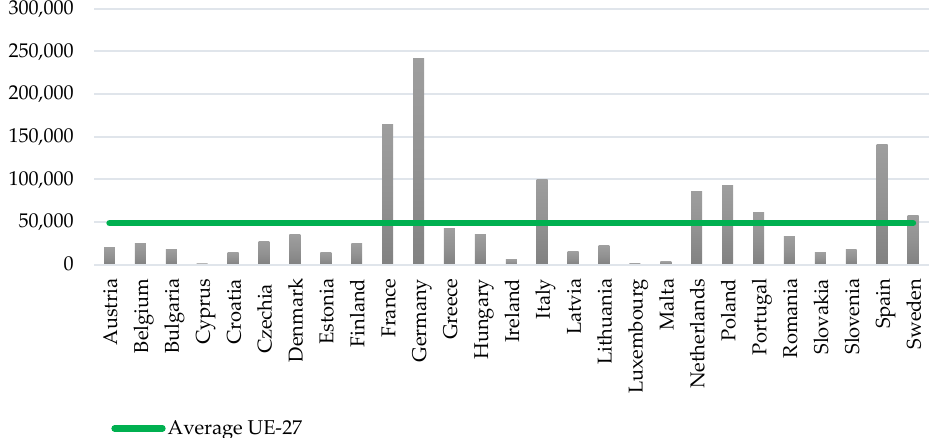
Figure 2. GJ in the RES sector (number of people employed) in EU countries in 2020. Source: Authors’ elaboration based on EurObserv’ER data.